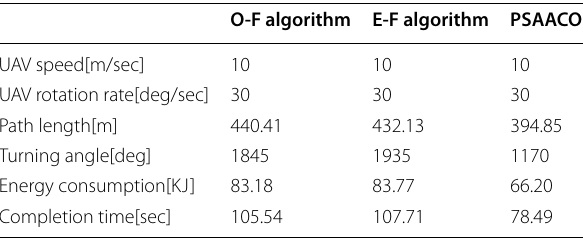
Table 12 Experiments on area 1 for performance comparison between PSAACO and algorithm in